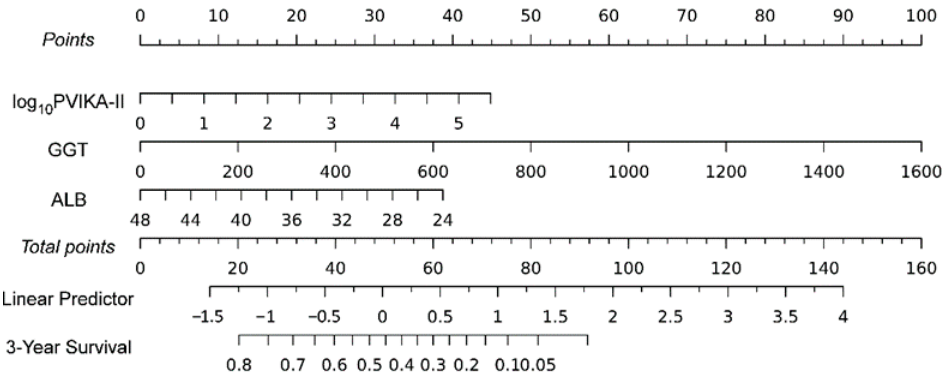
Figure 3. A prognostic nomogram for the survival at the 3-year follow-up in hepatocellular carci- noma.